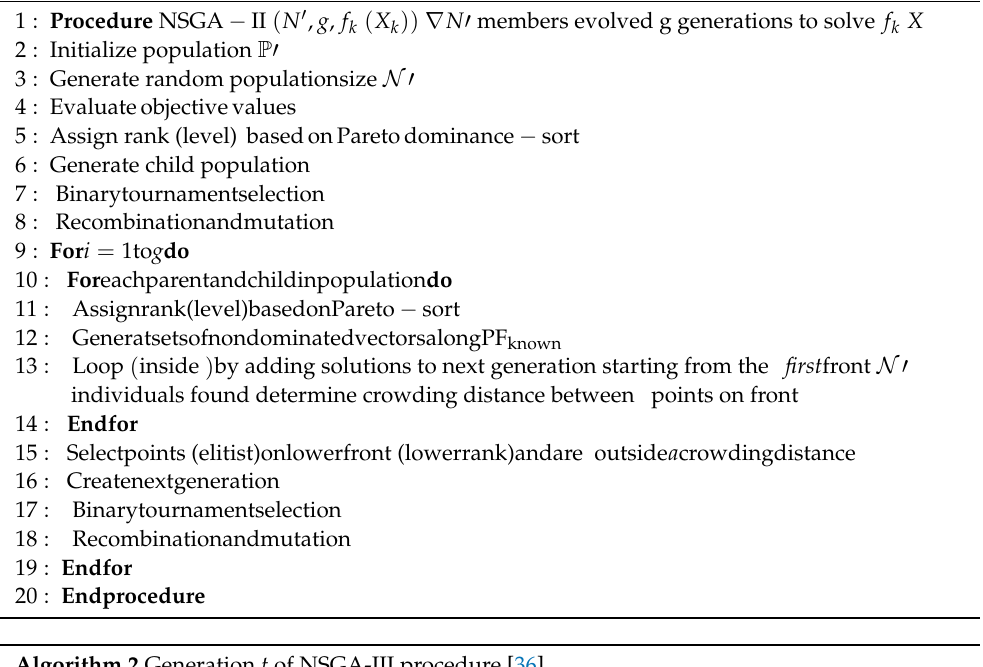
Algorithm 1 NSGA-II algorithm [35].